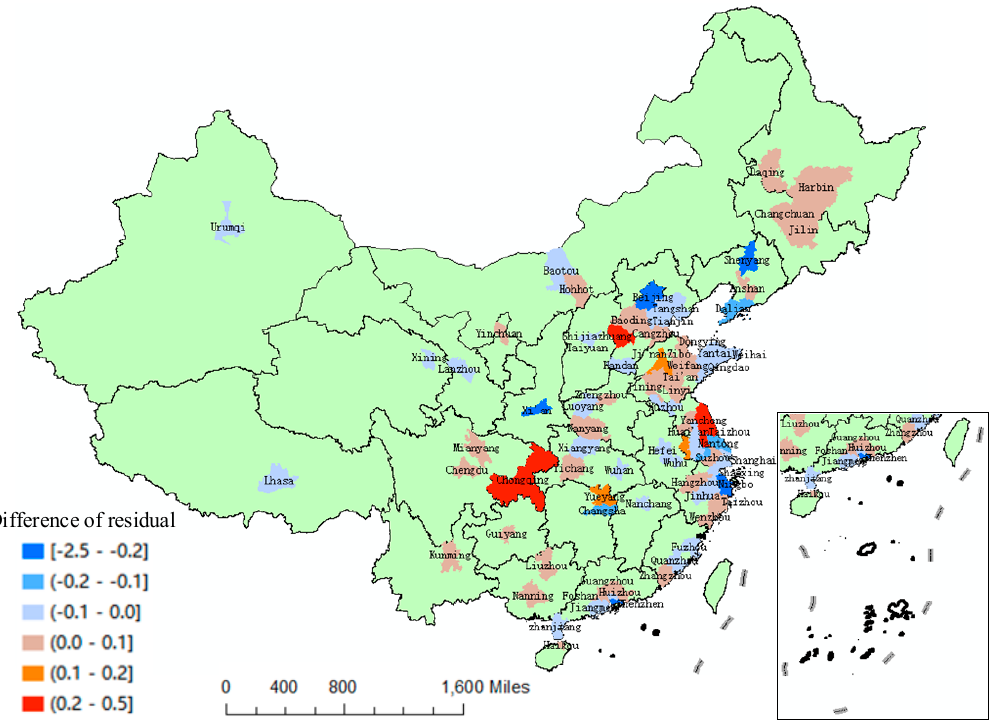
Figure 16. Distribution of absolute residual differences.